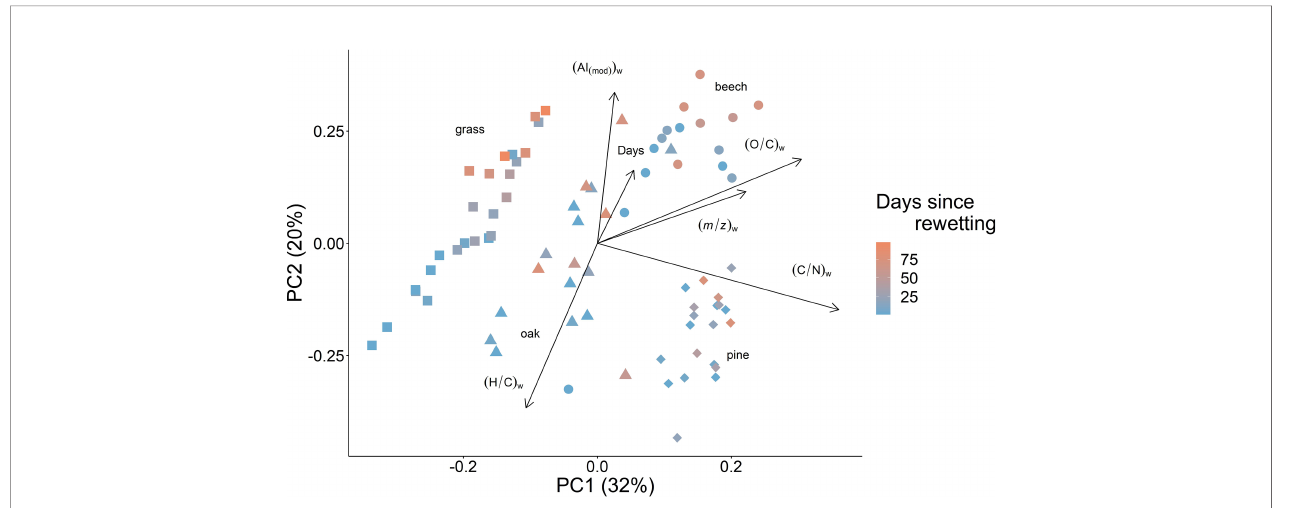
FIGURE 5 | Principal coordinate analysis (PCoA) plot of sum formulae and their relative intensities at 5 and 10 cm depth. Color indicates the number of days following rewetting from 0 to 98 days after the 2018 summer drought. “ Days ” is also plotted as an environmental variable to better visualize the overall trend. The weighted mean of carbon to nitrogen ratio (C/N) w , mass to charge ratio (m/z) w , oxygen to carbon ratio (O/C) w , hydrogen to carbon ratio (H/C) w and modi fi ed aromaticity index (AI (mod) ) w (31) are also plotted as environmental variables. All plotted environmental variables are signi fi cant (p < 0.05) and, with the exception of “ Days ” were calculated using the weighted mean as described in the “ Date Analysis and Visualisation ” section of “ Materials and Methods ” . Weighted average values for each sample are reported in Table S5